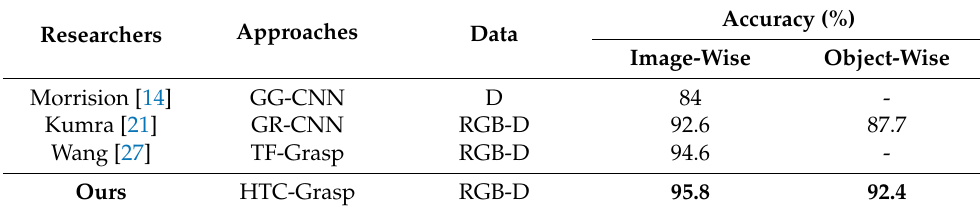
Figure 5. Comparison of predicted heatmaps on Jacquard Dataset. The first and second columns depict RGB and depth images, respectively. The third column displays the grasping rectangles and successful grasps are marked as rectangles. The final three columns depict heatmaps indicating the quality, angle, and width of the detected grasps. The quality heatmaps characterizes the degree of confidence that each pixel is a valid grasping location. Table 2. The statistical results on Jacquard Dataset.